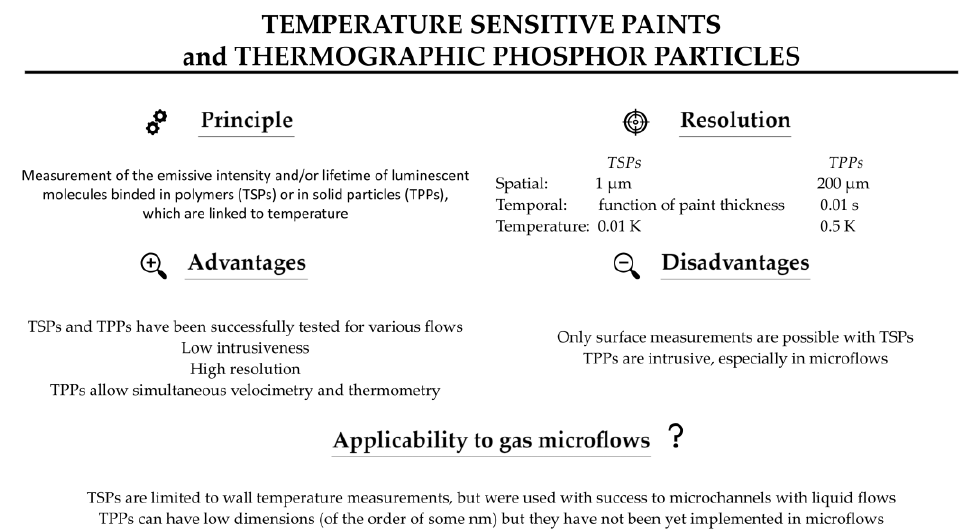
Figure 18. Summary of TSPs’ and TPPs’ features. Values of spatial resolutions are from [104] and [96], for TSPs and TPPs respectively; value of temporal resolution is from [96]; values of temperature resolution are from [103] and [101], for TSPs and TPPs respectively.